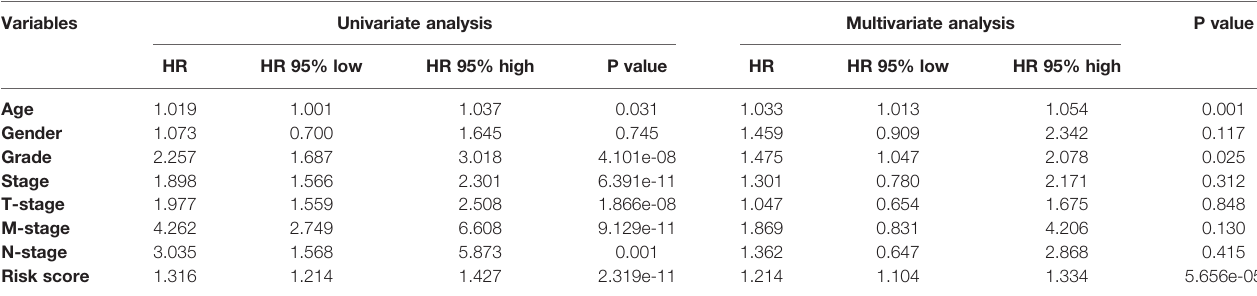
TABLE 2 | Univariate and multivariate COX analysis of ccRCC.